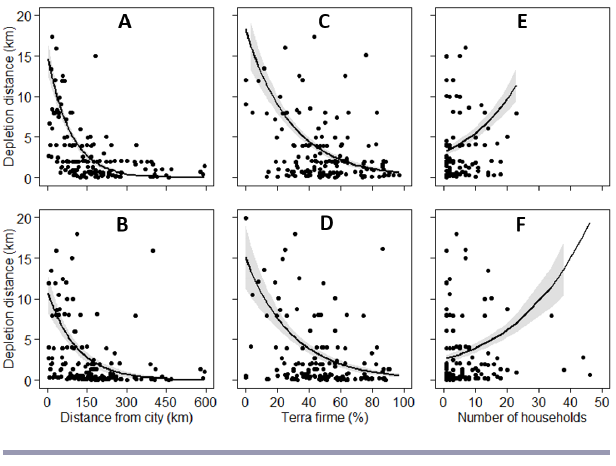
Fig. 4 . Model predictions (solid lines and standard errors in gray) from minimal generalized linear models (GLMs) for hunter-reported faunal depletion distances (solid dots) around 161 rural riverine settlements for selected significant predictors: (A-B) Travel distance from nearest urban center; (C-D) Coverage of unflooded terra firme within 5 km radius; (E-F) Settlement size (households). Species are: tapir, Tapirus terrestris (A,C), white-lipped peccary, Tayassu pecari (B,D,F), and woolly monkeys, Lagothrix spp. (E). The GLM results for all 10 study species are shown in Appendix 1, Table A3.